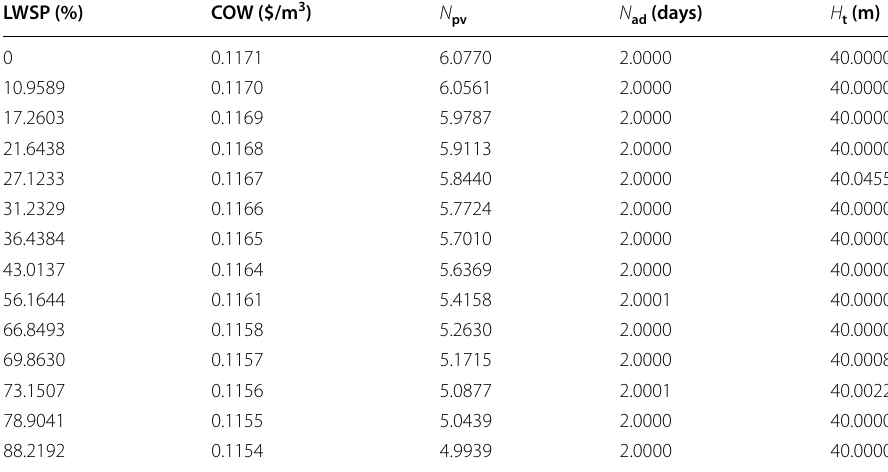
Table 6 Different optimal configurations of the studied system LWSP (%) COW ($/m 3 ) N